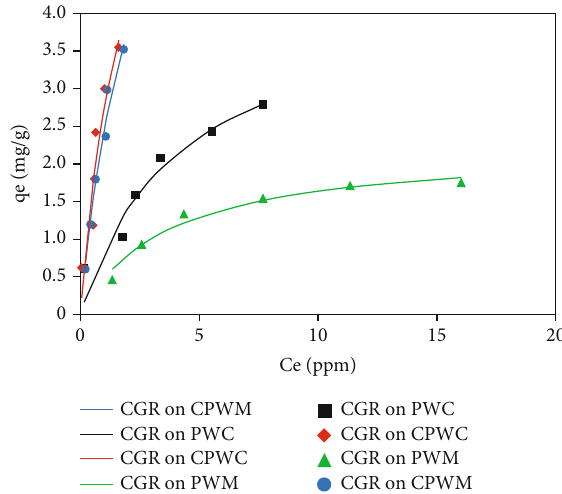
Figure 13: Nonlinear Langmuir isothermal